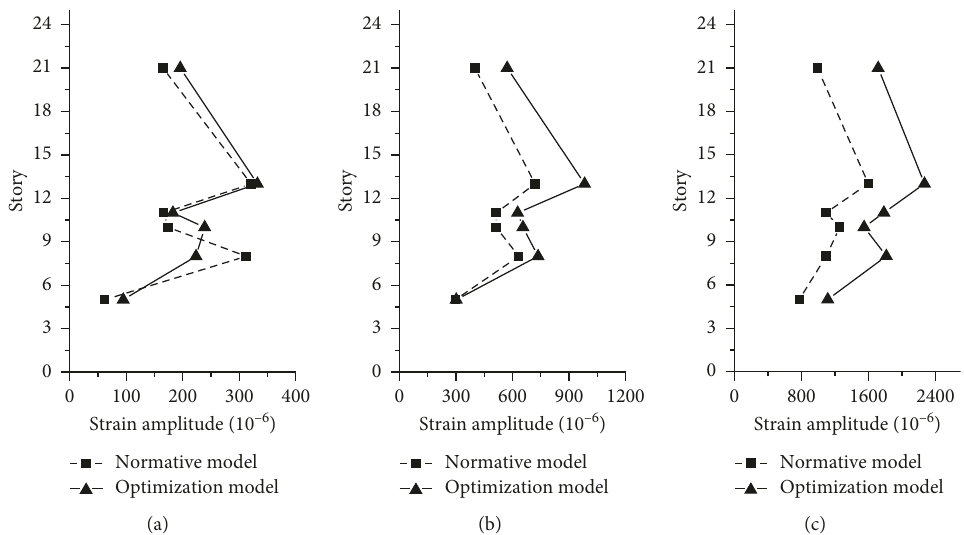
Figure 6: Maximum strain value of coupling beam at different story. (a) Frequent intensity 7, (b) basic intensity 7, and (c) rare intensity 7.